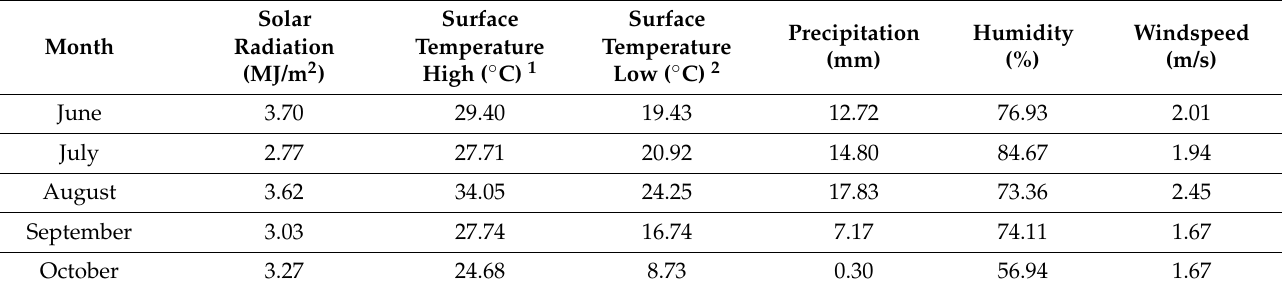
Table 2. Observed climate data.